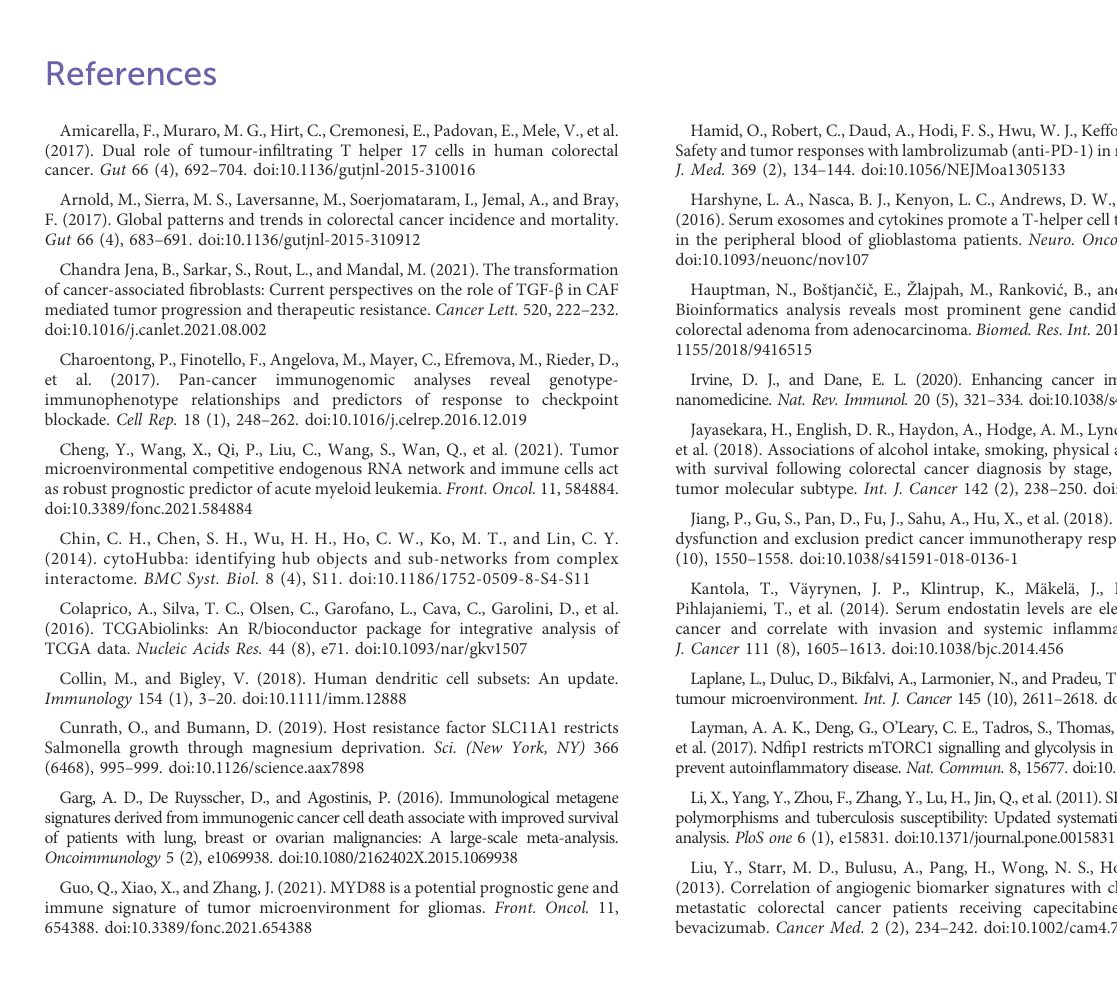
SUPPLEMENTARY FIGURE S1 GO (A) and KEGG (B) enrichment analyses for the overlapping DEGs of ImmuneScore and StromalScore groups. SUPPLEMENTARY FIGURE S2 Prognostic value of SLC11A1 for other digestive system tumors. (A – C) In STAD, PAAD and LIHC, high expression of SLC11A1 was associated with poor outcomes of OS. (D – I) In KIRC, BLCA, LAML, HNSC, UCEC